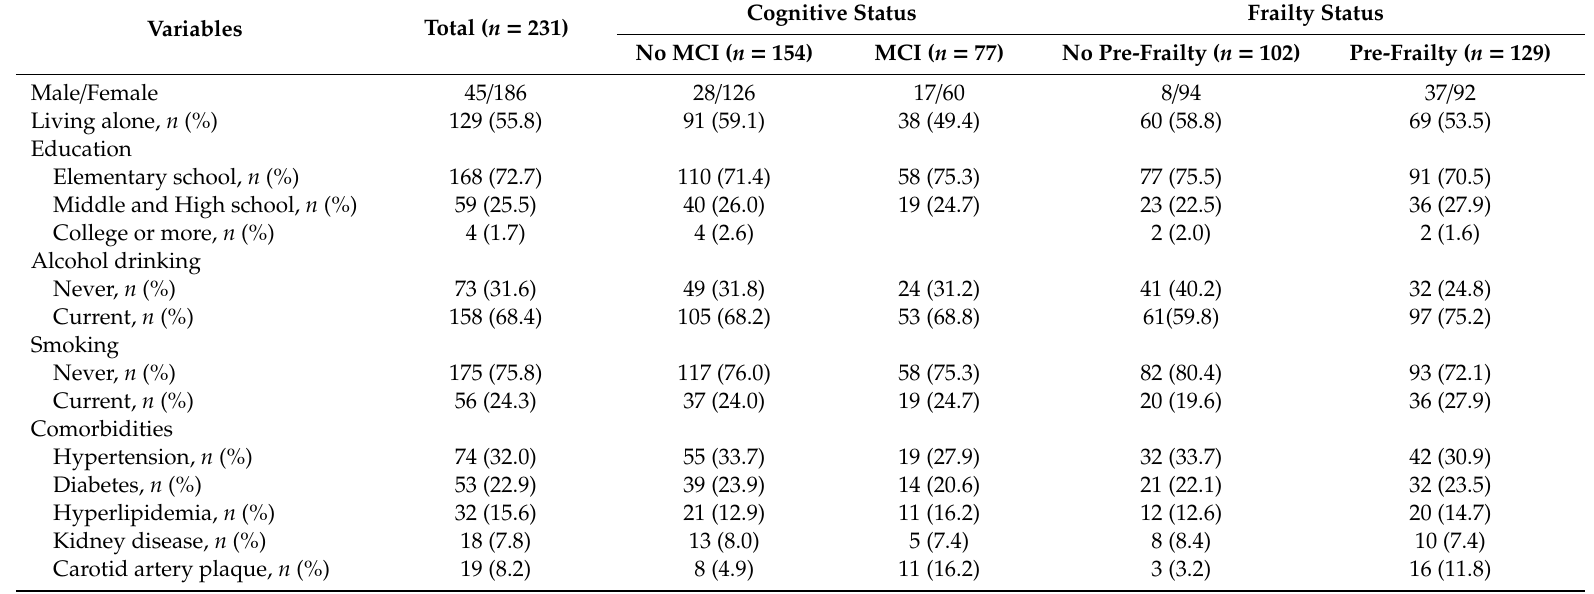
Table 1. General characteristics of study